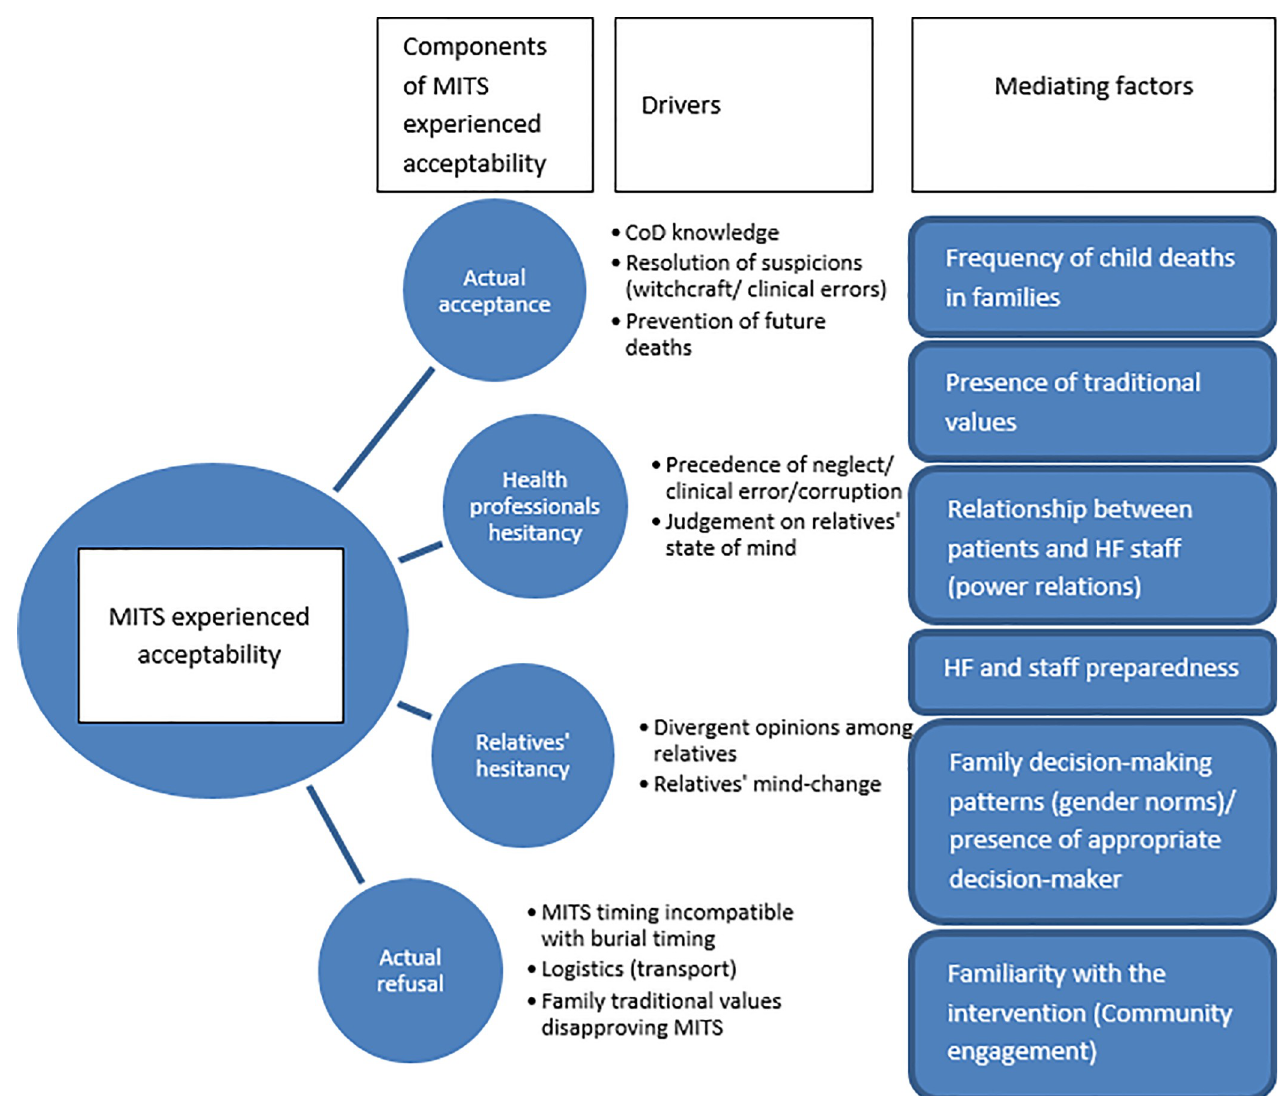
Fig 4. Dimensions of experienced acceptance of MITS. Components, drivers and mediating factors explaining MITS acceptance among relatives of deceased children during the implementation of MITS.